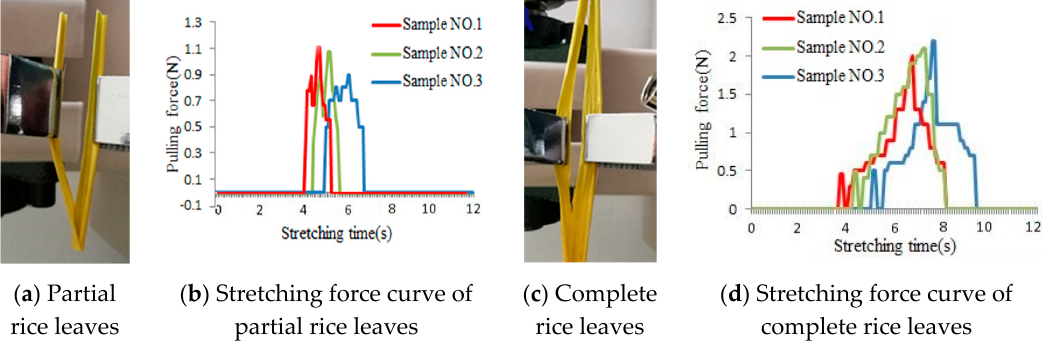
Figure 12. Transverse fracture states and stretching force curve of blades transverse tear.